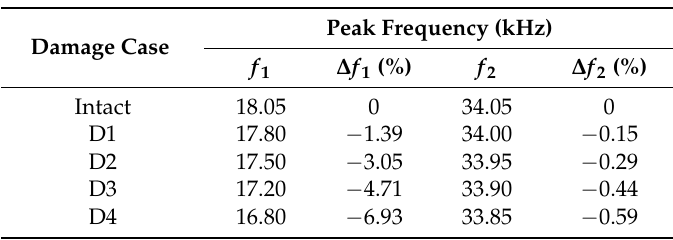
Figure 8. Numerical impedance signatures of FE model under contact stiffness-loss. Table 4. Change in the peak frequencies due to contact stiffness-loss.